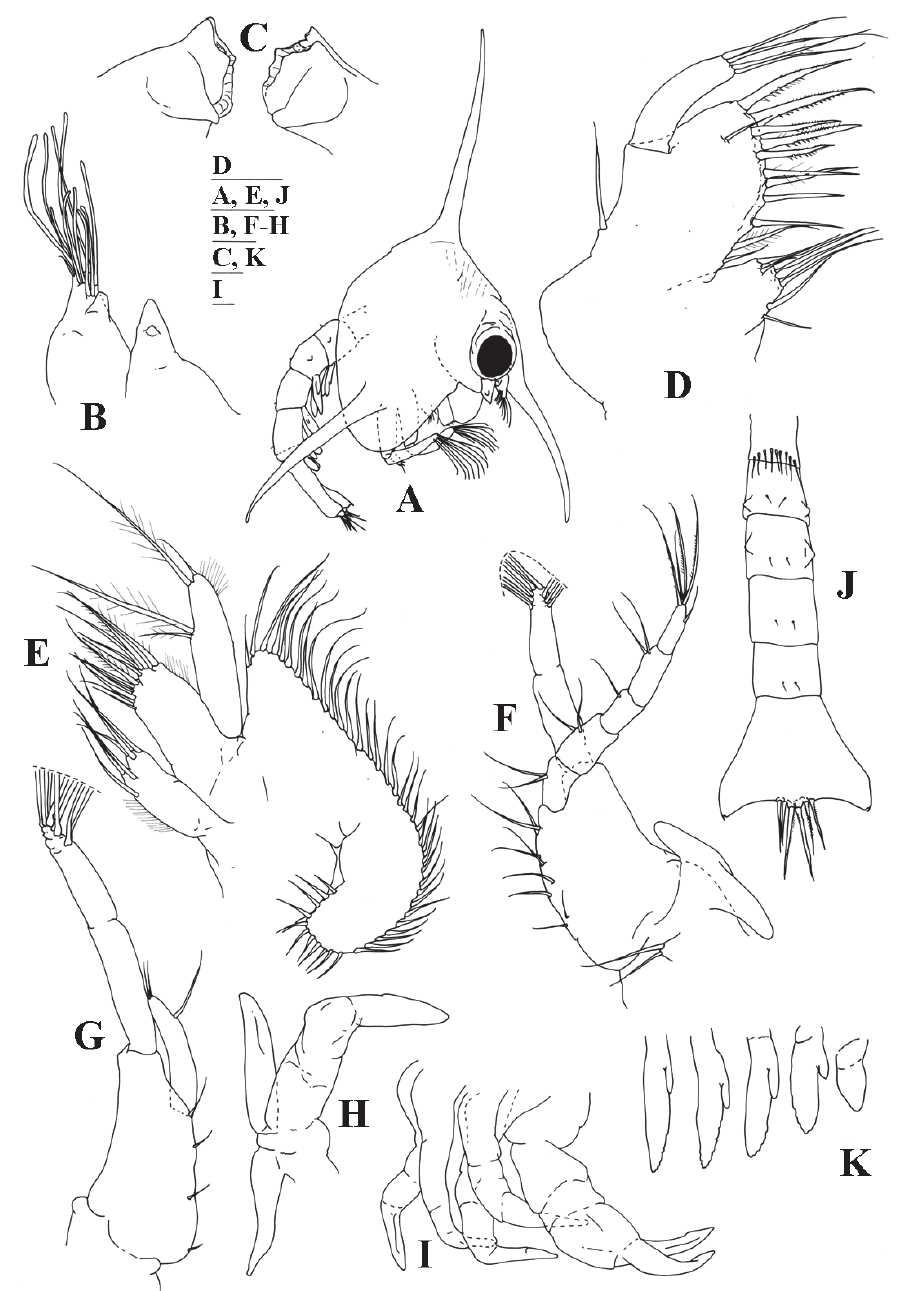
Fig . 4. – Ilia nucleus . Fourth zoea: a, general aspect, lateral view; B, antennule and antenna; C, mandibles; d, maxillule; e, maxilla; F, first maxilliped; g, second maxilliped; H, third maxilliped; i, pereiopods; J, dorsal view of abdomen and telson; K, pleopods. scale bars: 0.5